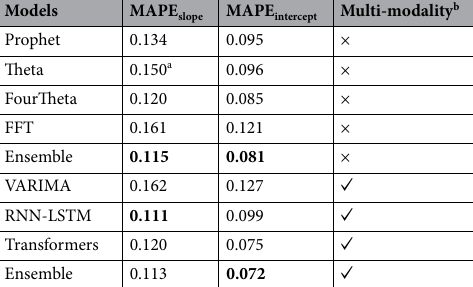
Table 1. Average MAPE for each selected model. Significant values are in [bold]. a Additive seasonality. b Multi-modal models required longer time-series. We limit the study of these models to time-series larger than 40 observations.